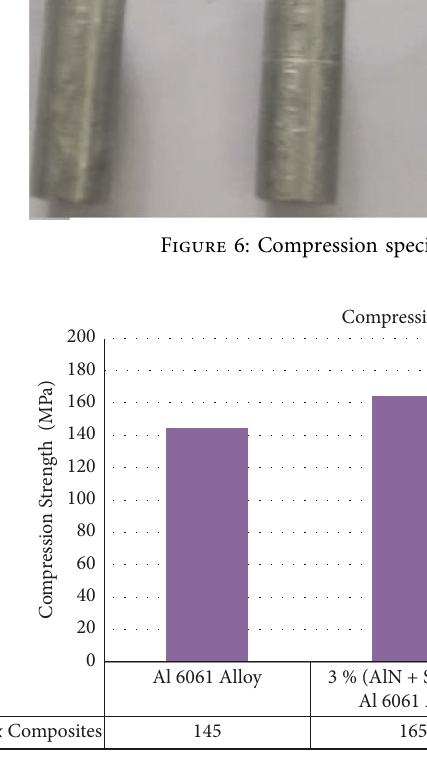
Figure 7: Compression test